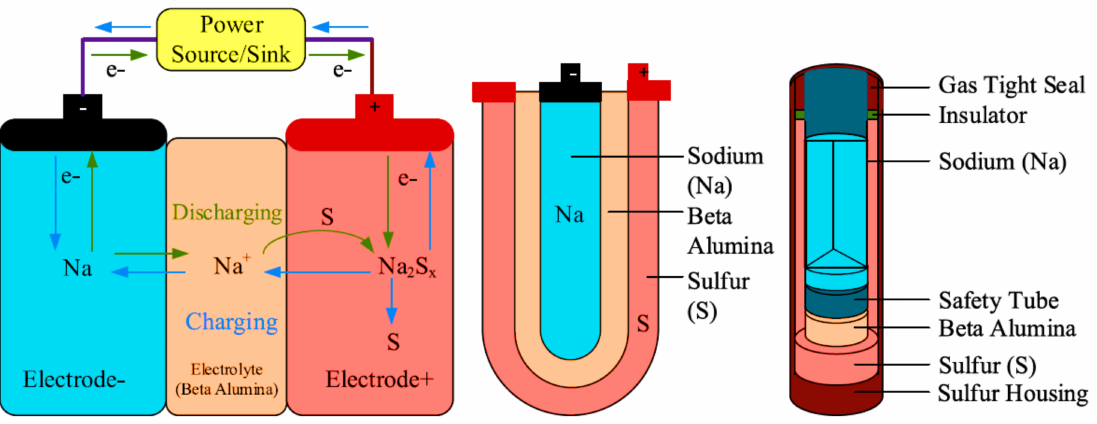
Figure 10. Sodium–sulfur battery [57].